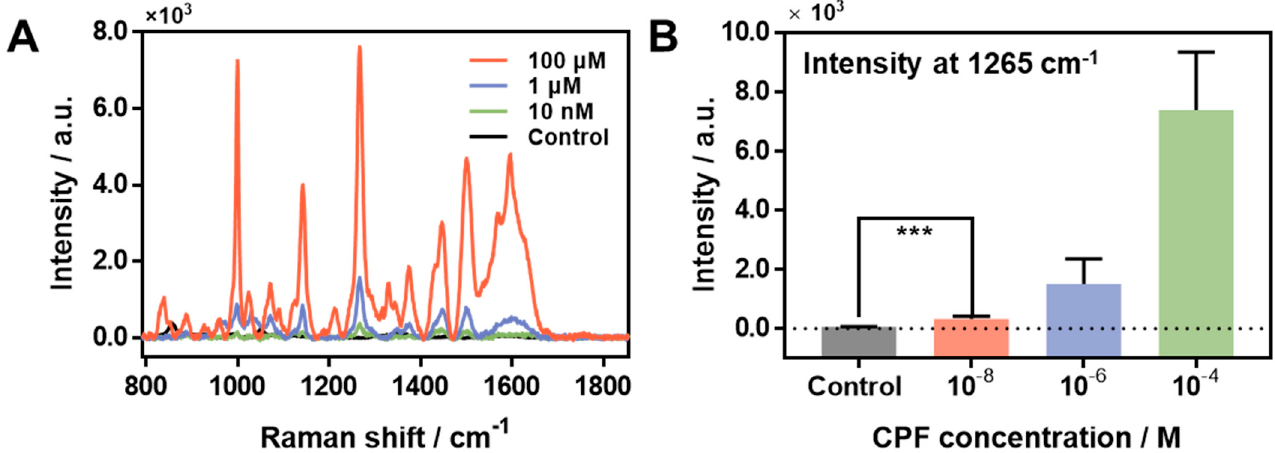
Figure 4. SERS measurement of CPF for various concentrations from 100 µ M to 0 M. ( A ) SERS spectra of CPF according to the concentration. ( B ) SERS intensities of the main characteristic peak (1265 cm − 1 ) of CPF depending on the concentration from 100 µ M to control. (Limit of detection: 500 nM, t -test result: *** p -value = 0.0001.)